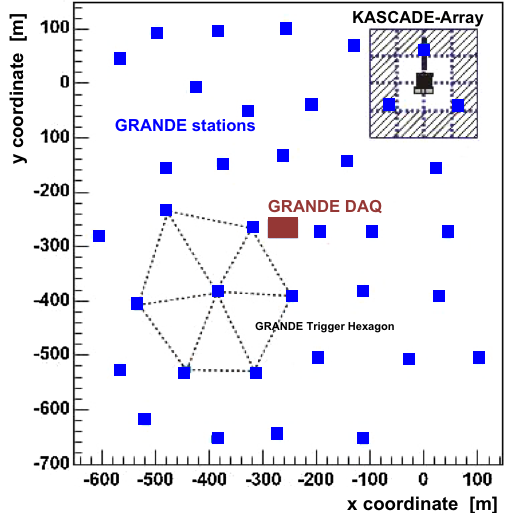
Fig. 5 The Grande Array layout as described in Sect. 2.1.3